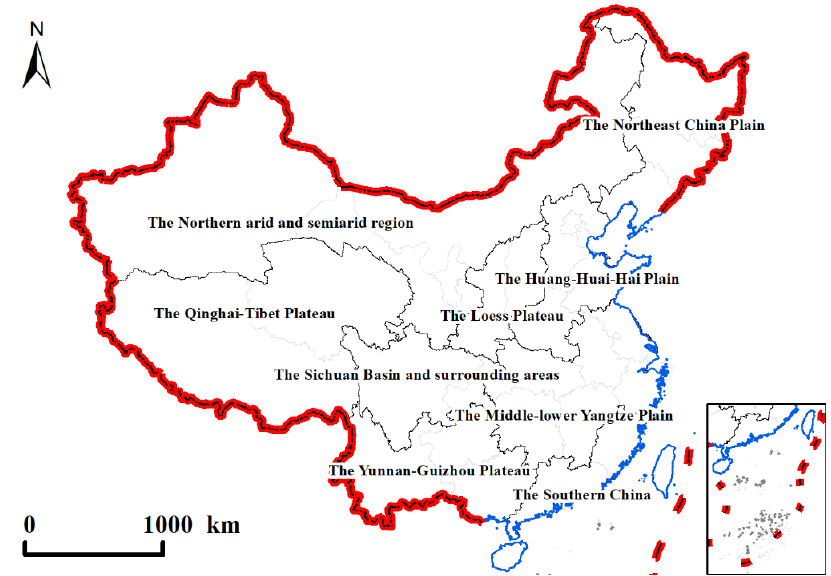
Figure 1. Agricultural zones in China .